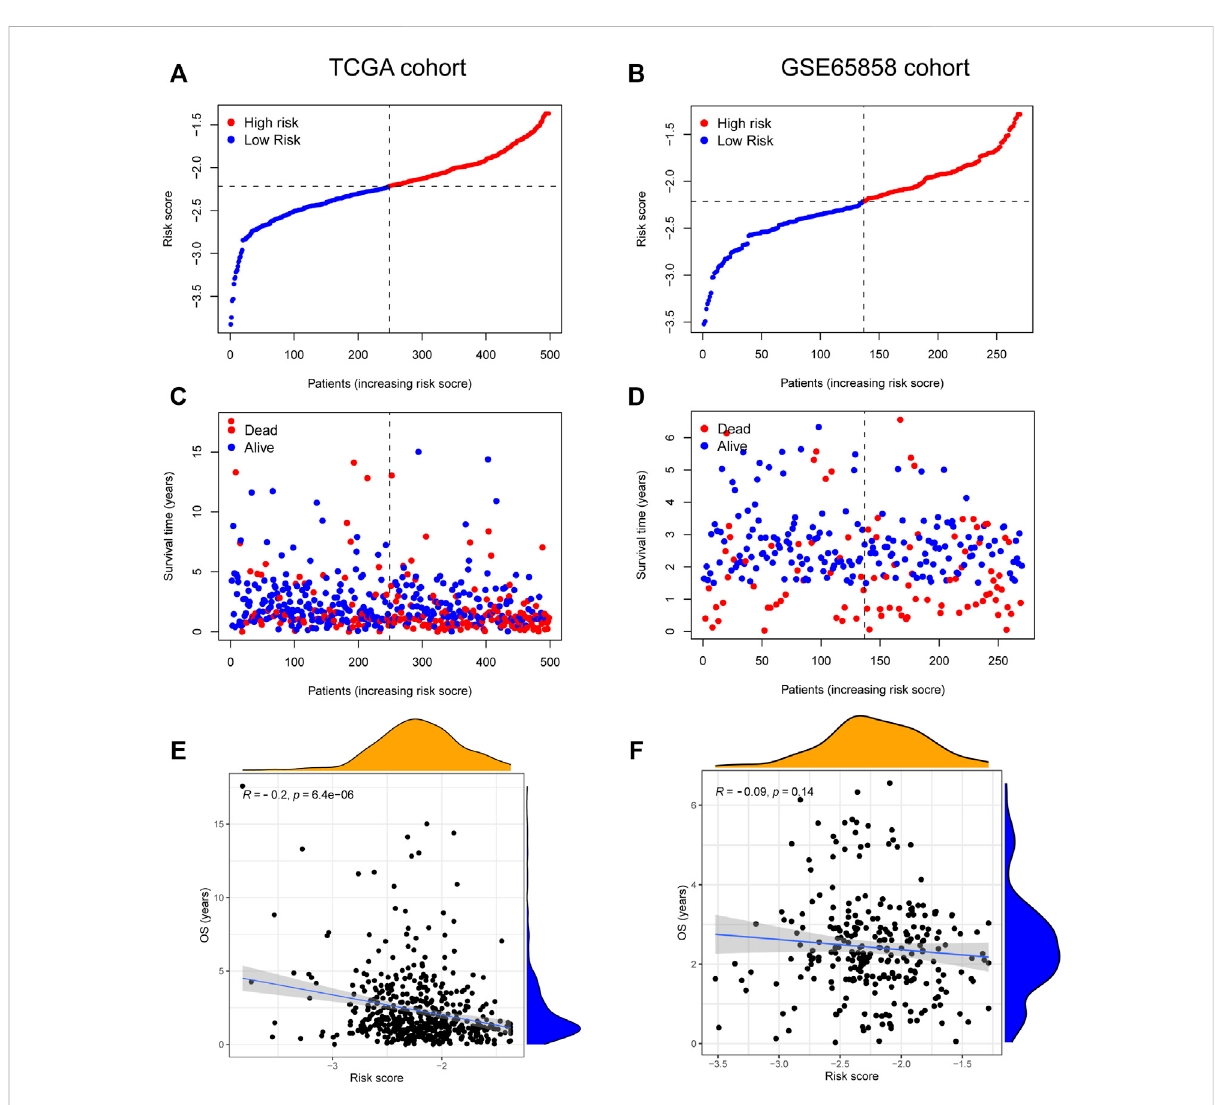
FIGURE 7 The relationship between risk score and HNSCC survival. (A – D) Distribution of risk score and survival status of 8-gene signature in TCGA (A,C) and GSE65858 (B,D) cohorts. (E,F) The correlation analysis between overall survival (OS) and risk score in TCGA (E) and GSE65858 (F)